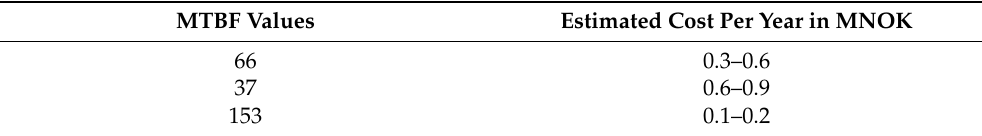
Table 1. Estimated cost per year for the maintenance based on average MTBF